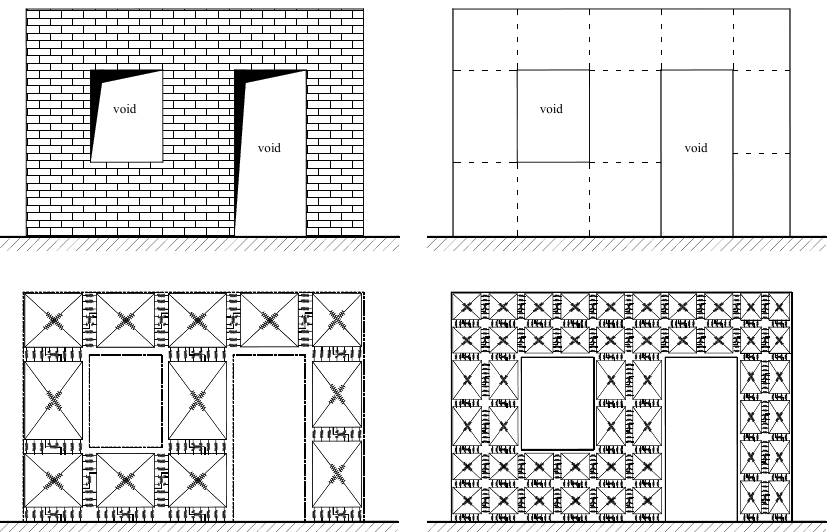
Figure 9. An example of a plane masonry wall and corresponding macro-element discretizations with different mesh resolutions.